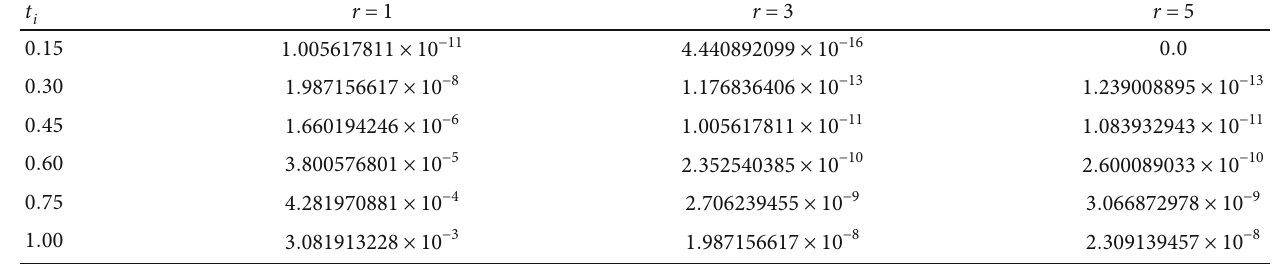
Table 1: Absolute errors for Example1 at β = 1 and n = 10 for di ff erent values of r .